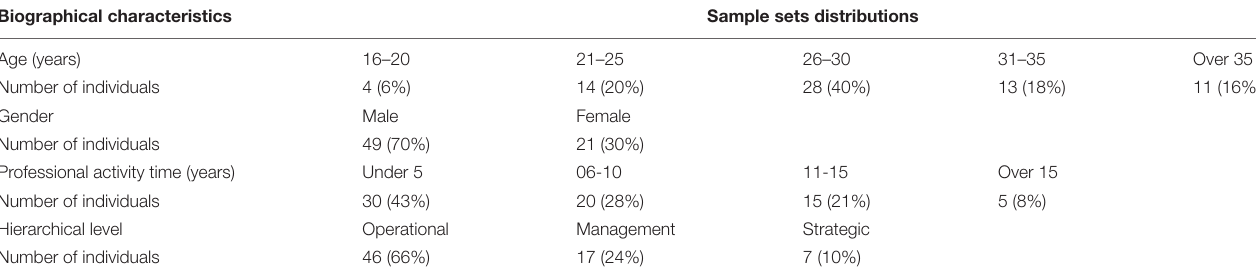
TABLE 2 | Sample characteristics.